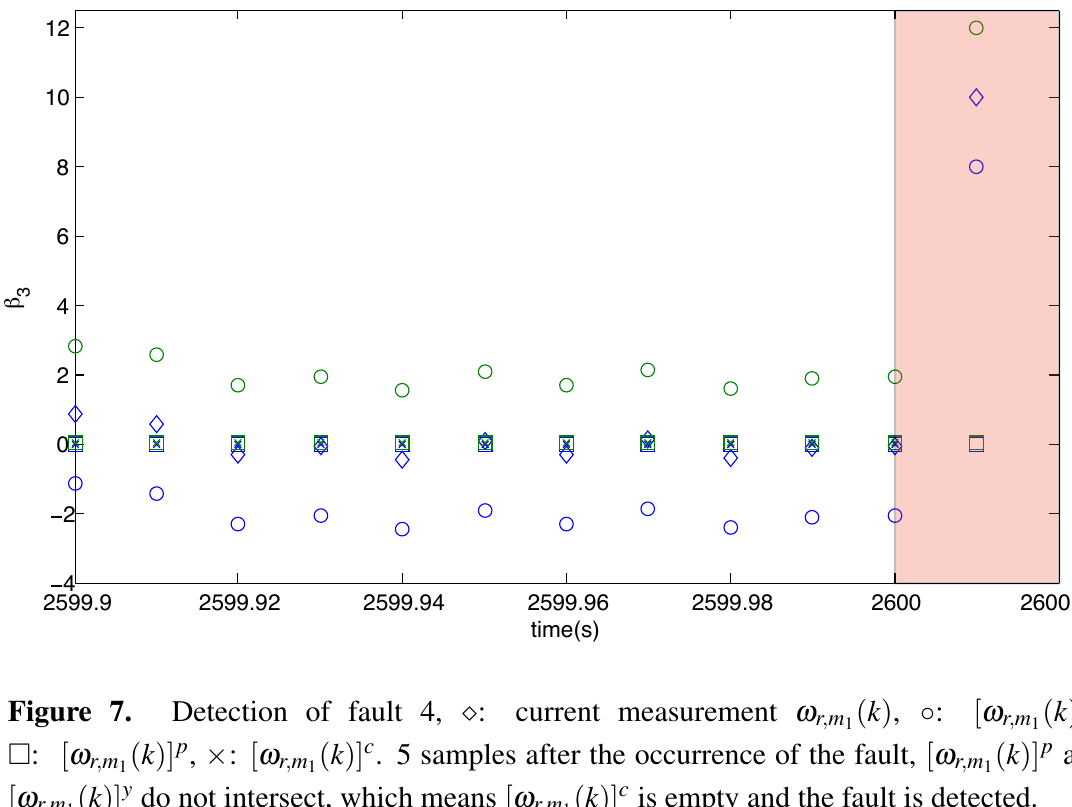
Figure 6. Detection of fault 3, (cid:5) : current measurement β × : [ β ( k )] c . One sample after the occurrence of the fault, [ β 3 intersect, which means [ β